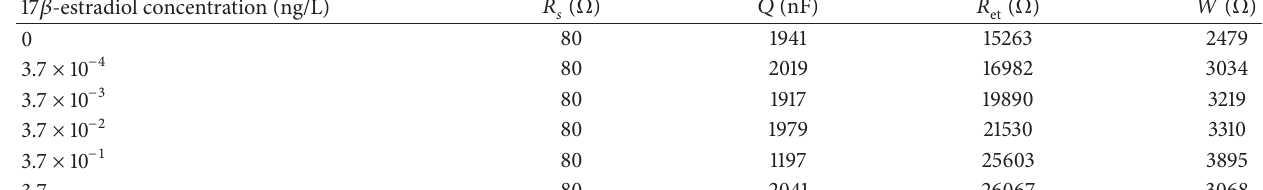
Table 1: Values of the equivalent circuit elements for 17 𝛽 -estradiol detection.